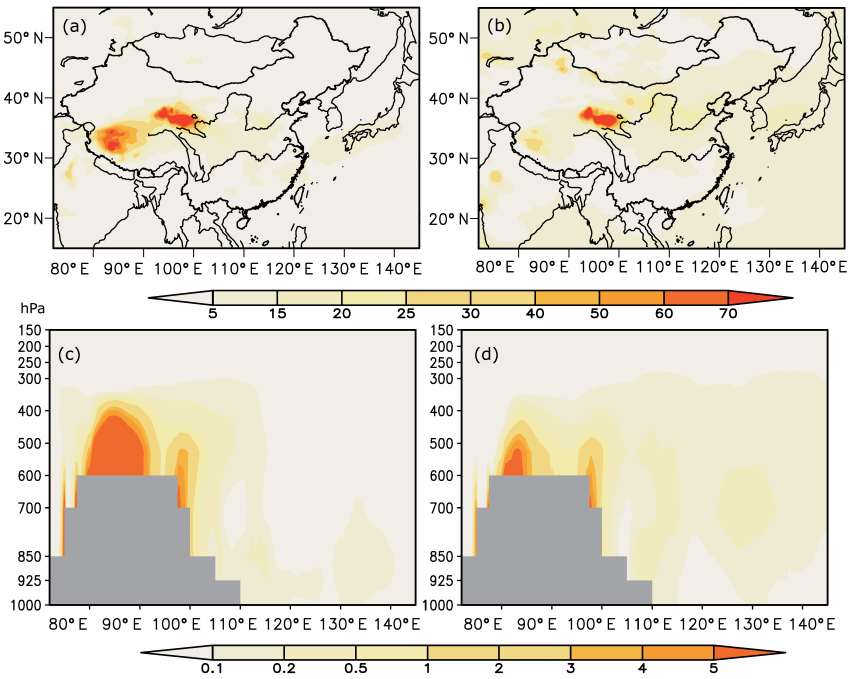
Figure 8. (a, b) Simulated differences (CON minus SEN) in the horizontal distribution of the column dust load (mgm − 2 ) and (c, d) the longitude–height cross section (averaged over 32–36 ◦ N) of the dust mixing ratio (µgkg − 1 ) for summer in heavy (a, c) and light dust years (b, d)